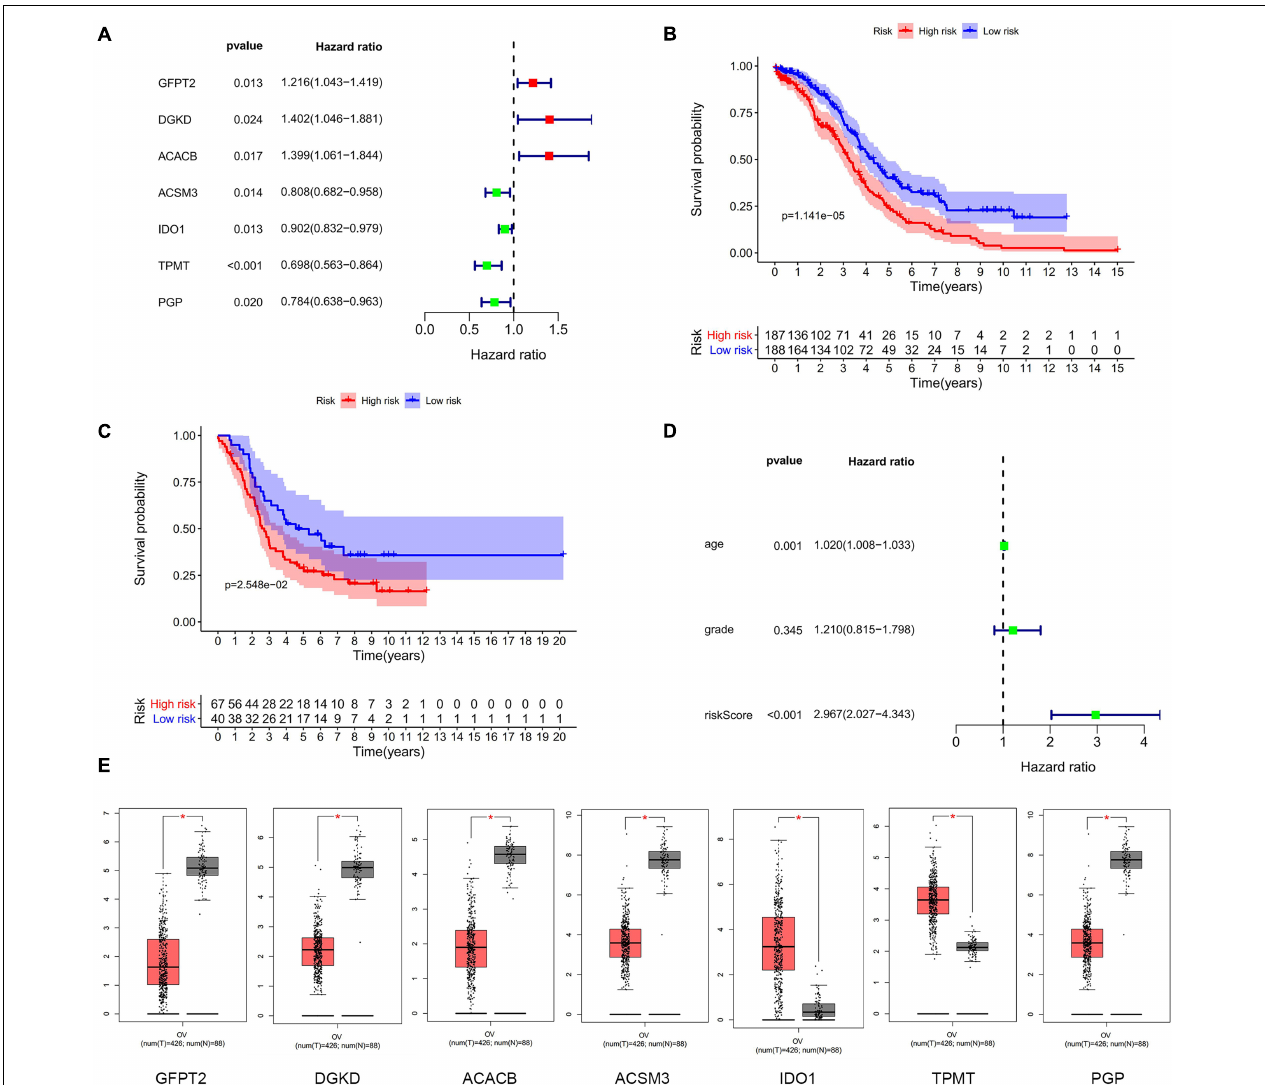
FIGURE 1 | The differently expressed metabolism-related genes panel. (A) Establishment of the seven metabolism-related genes’ panel correlated to OC patients outcomes. Red, high-risk genes; Green, low-risk genes. (B) Kaplan-Meier curve analysis of seven metabolism-related genes with OS in the training dataset of TCGA. Red, high-risk group; Blue, low-risk group. (C) Kaplan-Meier curve analysis of seven metabolism-related genes with OS in validation dataset of GEO. Red, high-risk group; Blue, low-risk group. (D) Forrest plots in the training cohort. (E) The transcription level of seven metabolism-related genes between human OC and normal tissues in TCGA. Red, tumor group; Gray, normal